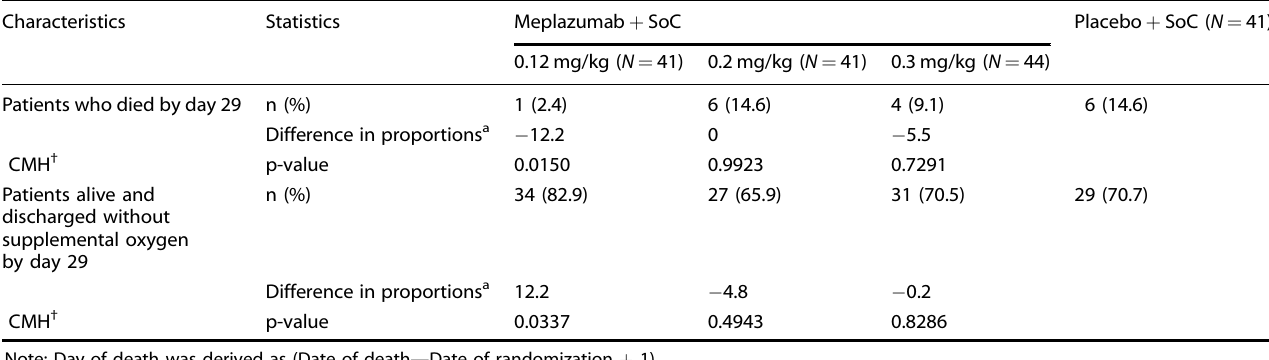
Table 2. Mortality and proportion of patients alive and discharged without supplemental oxygen on day 29 Characteristics